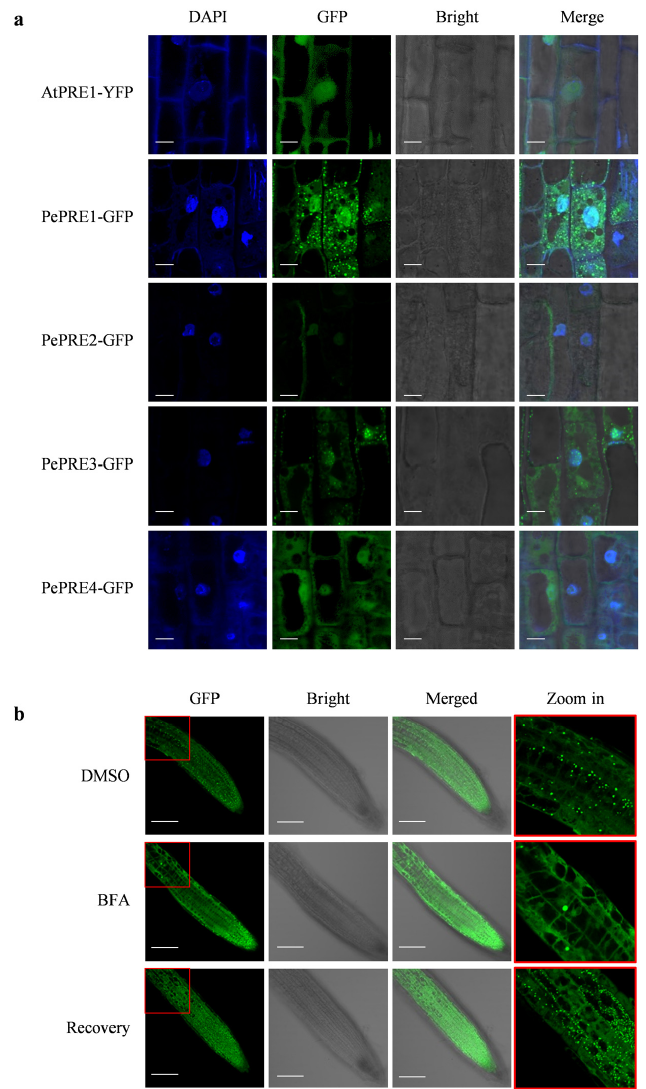
Figure 4. Subcellular localization of PRE proteins in Arabidopsis . ( a ) The root tip of the PePRE s’ trans- genic lines was observed by confocal microscope. Seedlings were grown on half MS medium with constant light for 7 days. Cells were stained with DAPI. Scale bar indicates 10 µm. ( b ) Subcellular localization of PePRE1-GFP by treating with or without BFA. The root tips of PePRE1 -OX #19 were observed by confocal microscope. Seedlings were grown on half MS medium with constant light for 4 days vertically. Scale bar indicates 100 µm.